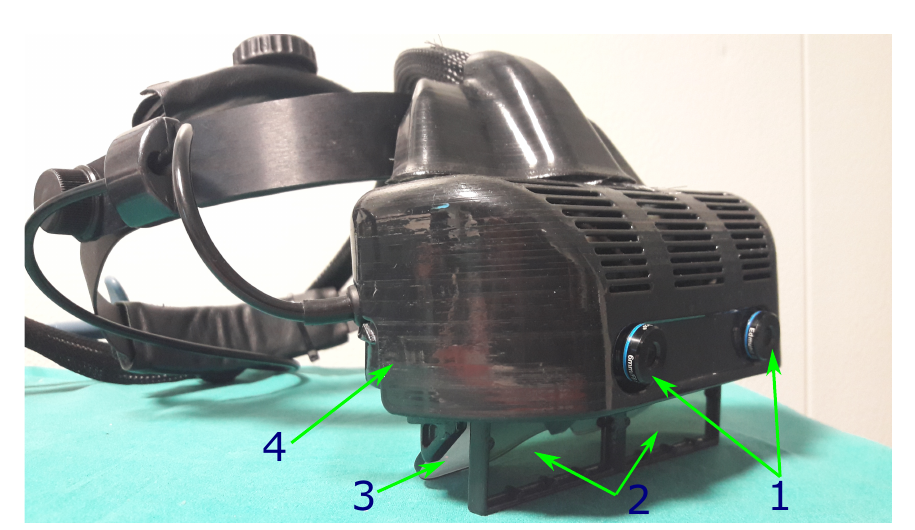
Figure 1. The custom-made hybrid video/optical see-through head-mounted display. 1 → Pair of stereo cameras for the inside-out optical tracking and the camera-mediated view. 2 → Pair of liquid-crystal (LC) optical shutters for the video-optical switching mechanism. 3 → Beam combiners of the see-through display. 4 → Plastic frame that holds all the components around the see-though